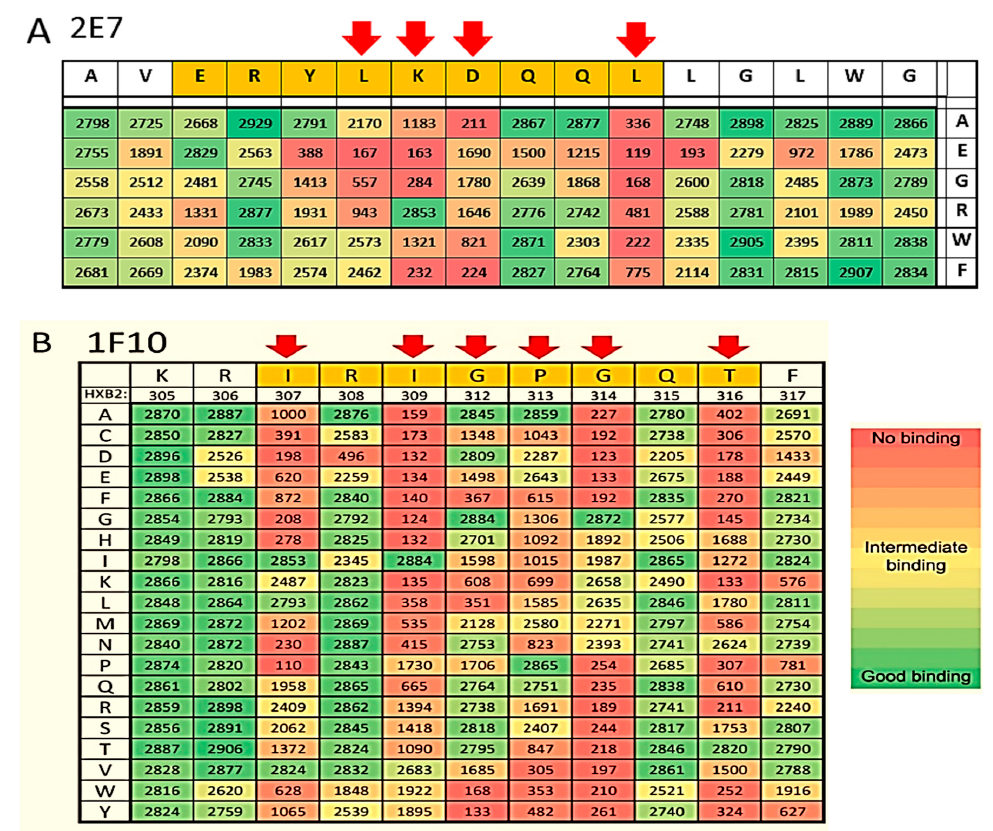
Figure 4. Epitopes Determination of the VHH 2E7, 11F1F and 1F10. After initial pepscan analyses, the amino acids in the gp140 envelop protein that interact with these VHH have been fine mapped by limited substitution of the amino acids of the epitopes of 2E7 ( A ) and full substitution for 1F10 ( B ). The key residues of the interaction are indicated by red arrows .